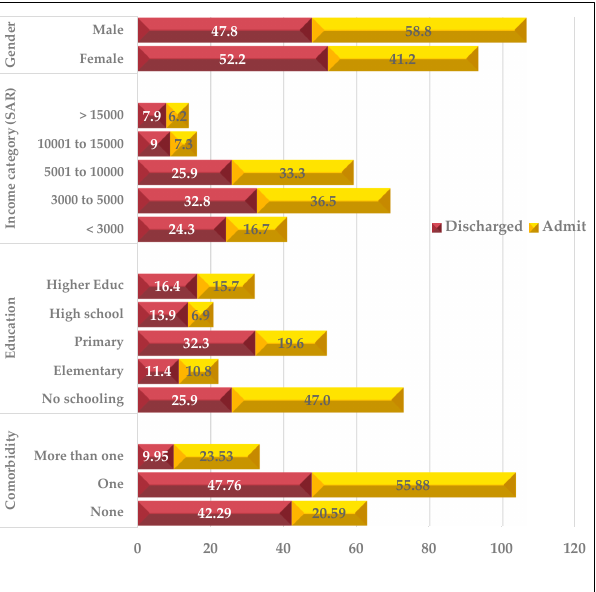
Figure 1. ED disposition by demographic, socioeconomic, and clinical characteristics (%), n = 303. Table 1 details patients’ socioeconomic characteristics and association with disposi- tion decisions. The mean age of the patients was 50.9 (SD = 21.4, Range 18 to 101). There